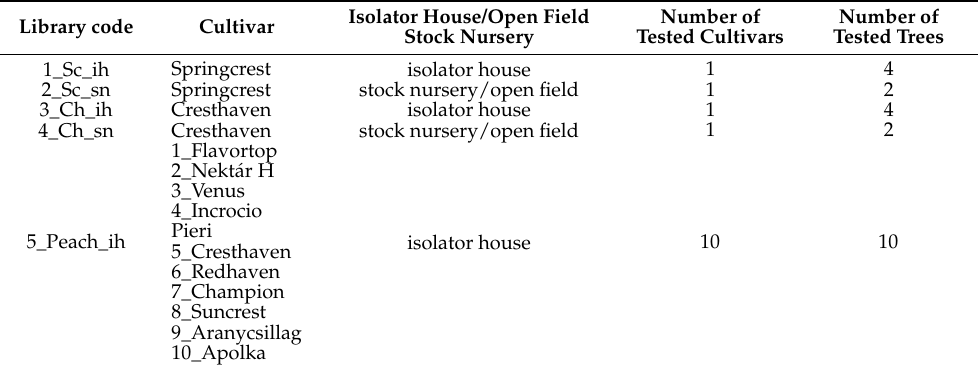
Table 1. Basic information of the sampled varieties with their respective small RNA library codes. (Sc: Springcrest; Ch: Cresthaven; ih: isolator house; sn: stock